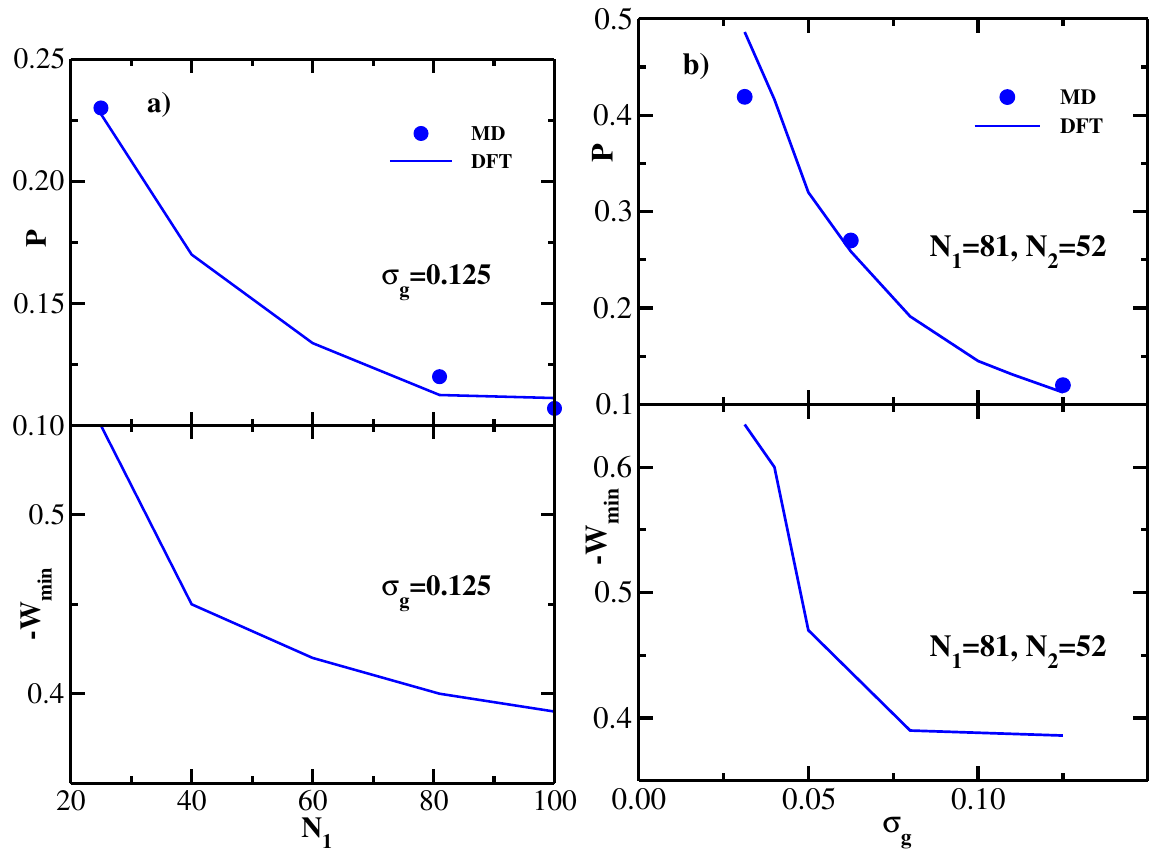
Figure 6. ( a ) Upper panel: overlap P defined via Equation (20) as a function of the longer grafted chain length N 1 for two equimolar bidisperse flexible brushes at equilibrium separation; grafting density is σ g = 0.125, and the shorter grafted chain length N 2 is given by the integer part of the value 16 N 1 /25. Solid line shows the present DFT results, and symbols are from MD simulations [26]. Lower panel: DFT results for the (negative) minimum of the PMF between two equimolar bidisperse flexible brushes as a function of the longer grafted chain length N 1 ; grafting density is σ g = 0.125, and the shorter grafted chain length N 2 is given by the integer part of the value 16 N 1 /25. ( b ) Upper panel: overlap P defined via Equation (20) as a function of the grafting density σ g for two equimolar bidisperse flexible brushes at equilibrium separation; grafted chain lengths are N 1 = 81 and N 1 = 52. Solid line shows the present DFT results, and symbols are from MD simulations [26]. Lower panel: DFT results for the (negative) minimum of the PMF between the two equimolar bidisperse flexible brushes as a function of the grafting density σ g ; grafted chain lengths are N 1 = 81 and N 2 =